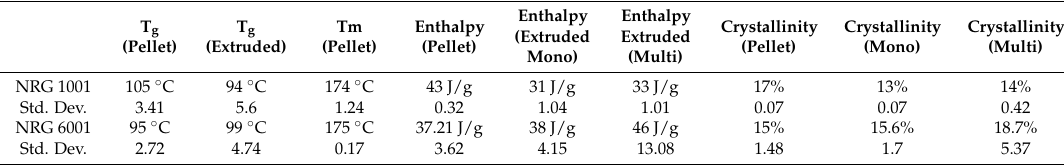
Figure 5. DSC curves for Vestamid NRG 6001 ( a ) Pellets, ( b ) Monofilament fibres, and ( c ) Multifilament fibres. Table 3. Differential scanning calorimetry analysis for Vestamid polymers.